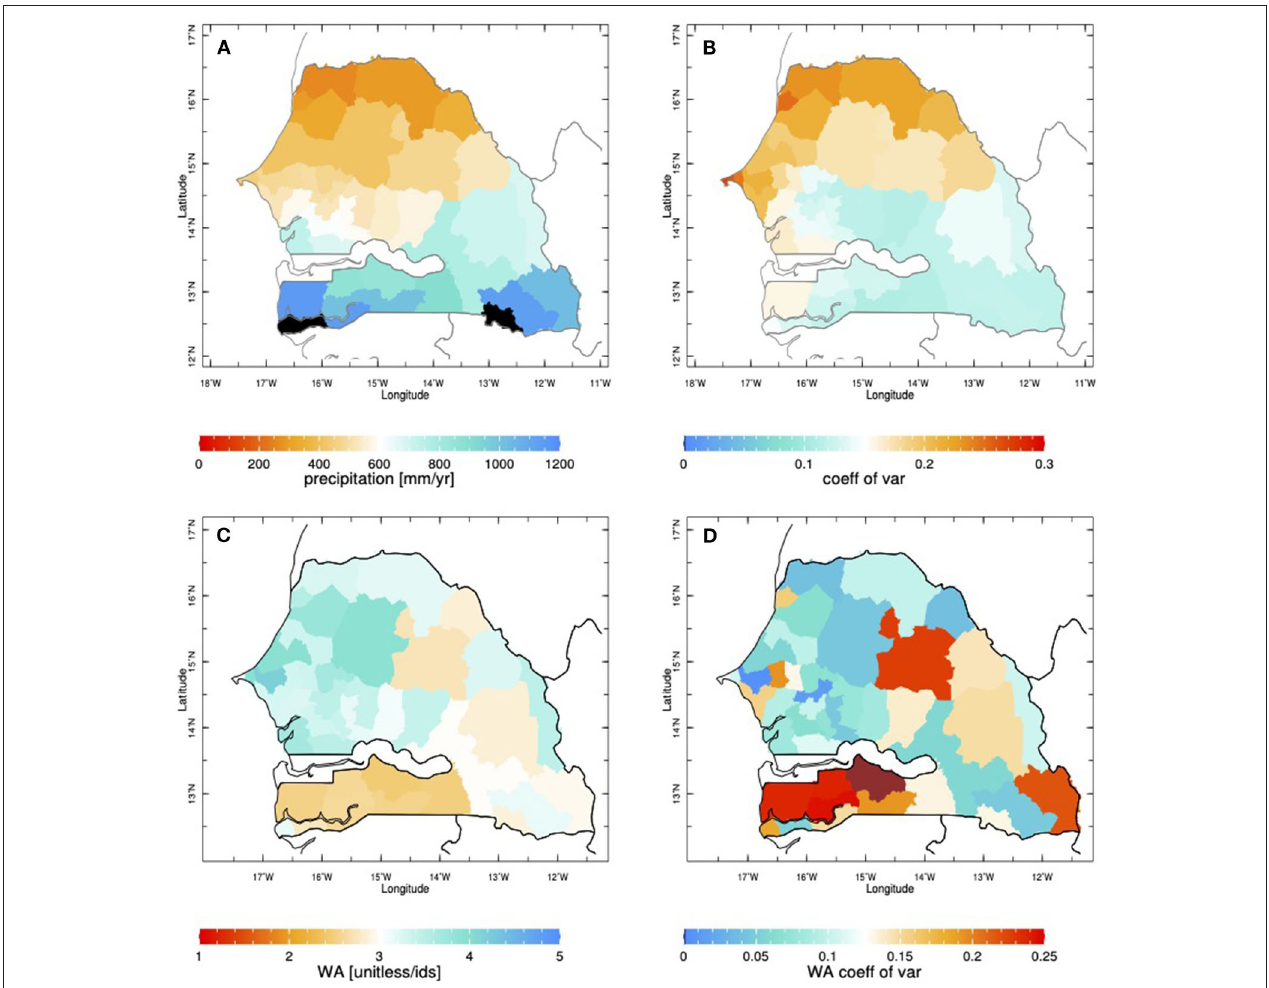
FIGURE 1 | Climatology, or average, and variability, measured by the coefficient of variation, of precipitation and food security status. Precipitation is from CHIRPS, and is taken over the core rainy season months of July to September. Average (A) and coefficient of variation (B) are computed over 2000–2019. Food security status is measured by the weighted average of membership into the 5 clusters originally defined in IN2020, defined in Equation (1). Average (C) and coefficient of variation (D) are computed over the 3 years surveyed–2013, 2014, and 2016—by